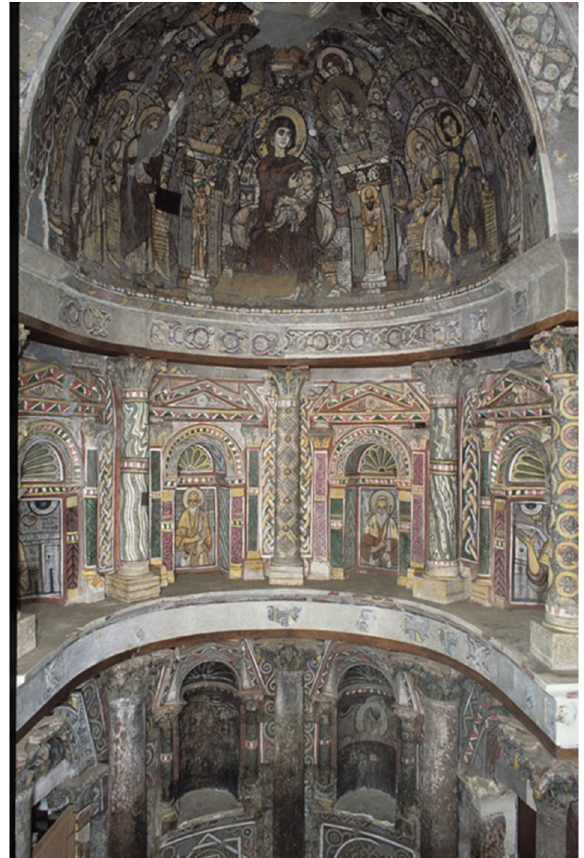
Figure 21. Interior of the Red Monastery Church, Sohag, Egypt, northern lobe of the triconch, paintings dated c. 6th century CE. Reproduced by permission of the American Research Center in Egypt, Inc. (ARCE). This project was funded by the United States Agency for International Development (USAID). Photo: Patrick